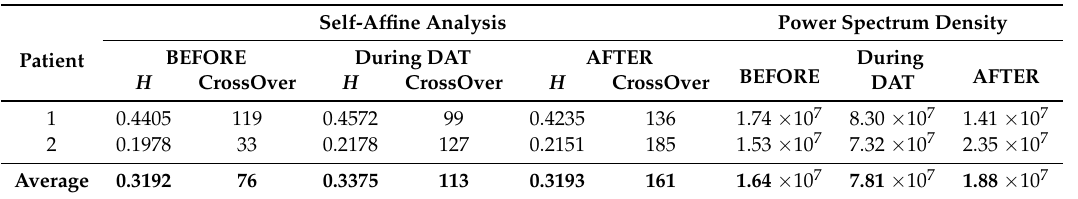
Table 2. Summary of the experimental results of Intervention Patient (Patient 1) and Control Patient (Patient 2), average of both patients is presented in